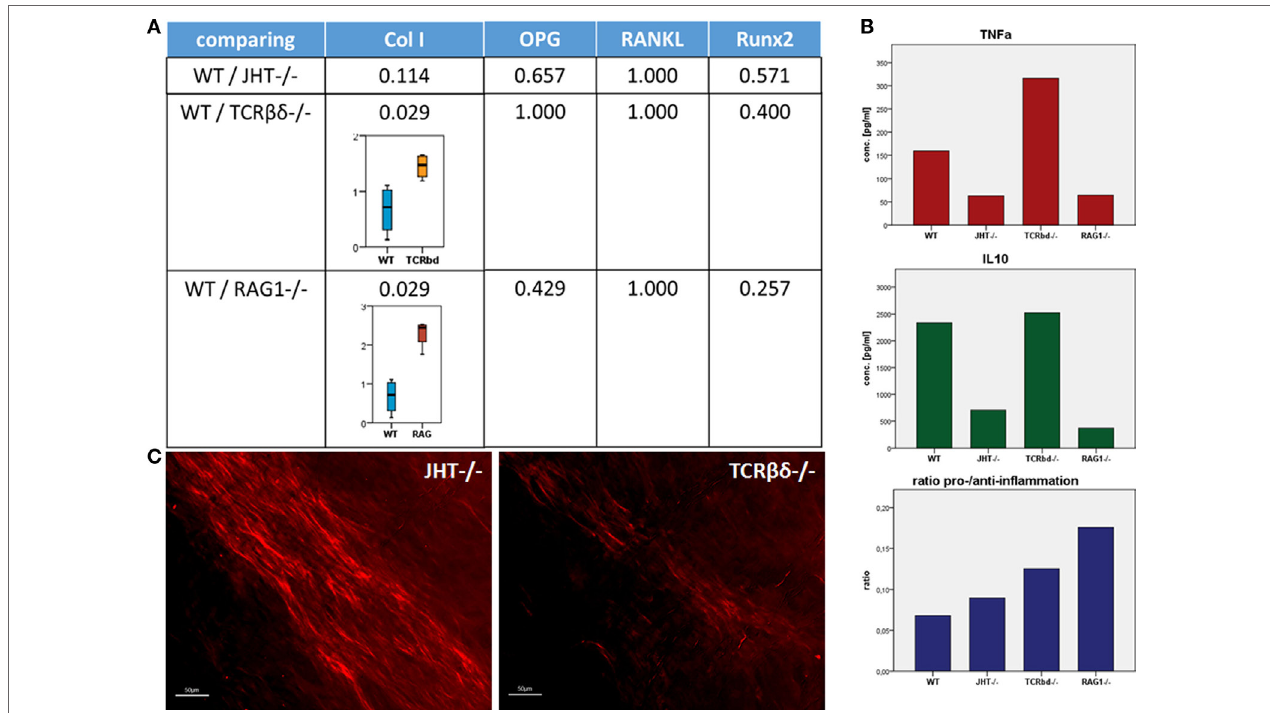
FigUre 13 | collagen i deposition is irregular in recombination activating gene 1 homozygous knockout (rag1 − / − ) and T cell receptor β and δ chain homozygous knockout (Tcr βδ − / − ) mice . (a) Using quantitative reverse transcription polymerase chain reaction a significant difference in expression of collagen I was detected in bone marrow cells of RAG1 − / − and TCR βδ − / − mice when compared to wild-type (WT). Bone markers such as osteoprotegerin (OPG), receptor activator of NF-kB ligand (RANKL), and Runt-related transcription factor 2 (RUNX2), however, were not affected. (B) Splenocytes were activated with LPS, and conditioned medium was analyzed to determine pro-inflammatory (TNF α ) and anti-inflammatory (interleukin 10) cytokines. While these factors showed no correlation in itself, the ratio of pro- and anti-inflammatory signals showed higher pro-inflammatory signaling in RAG1 − / − and TCR βδ − / − when compared to WT and JHT − / − . This indicates an influence of the cytokine pattern of T and B cells on the bone forming process. (c) Conditioned medium was added in an in vitro assay of mesenchymal stem cells (MSCs), and collagen deposition was analyzed using a Sirius red staining and polarization microscopy. Collagen deposition by MSCs cultivated with conditioned medium of JHT − / − splenocytes showed a stronger and more regular orientation than collagen deposition of MSCs cultivated with conditioned medium of TCR βδ − / −